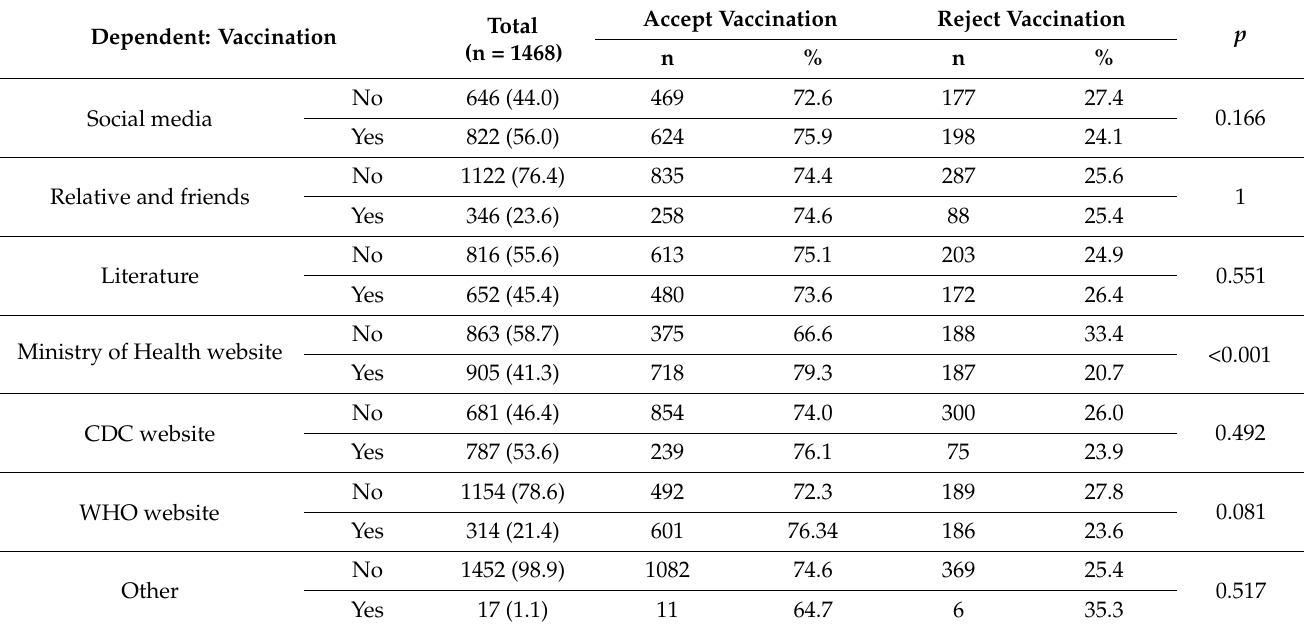
Table 3. Source of information about COVID-19.